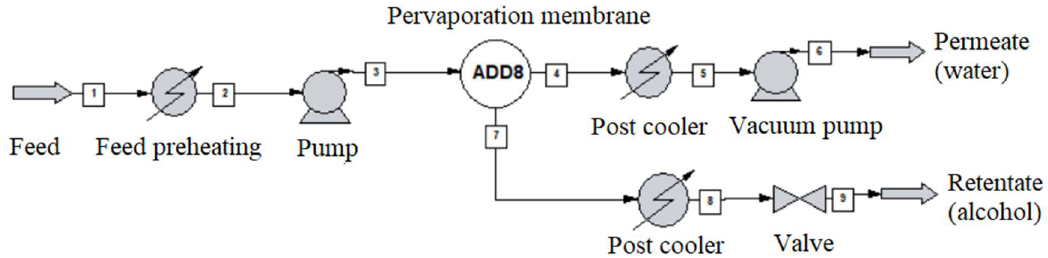
Figure 3. Flowsheet of hydrophilic pervaporation membrane (in case of organophilic reverse product available).